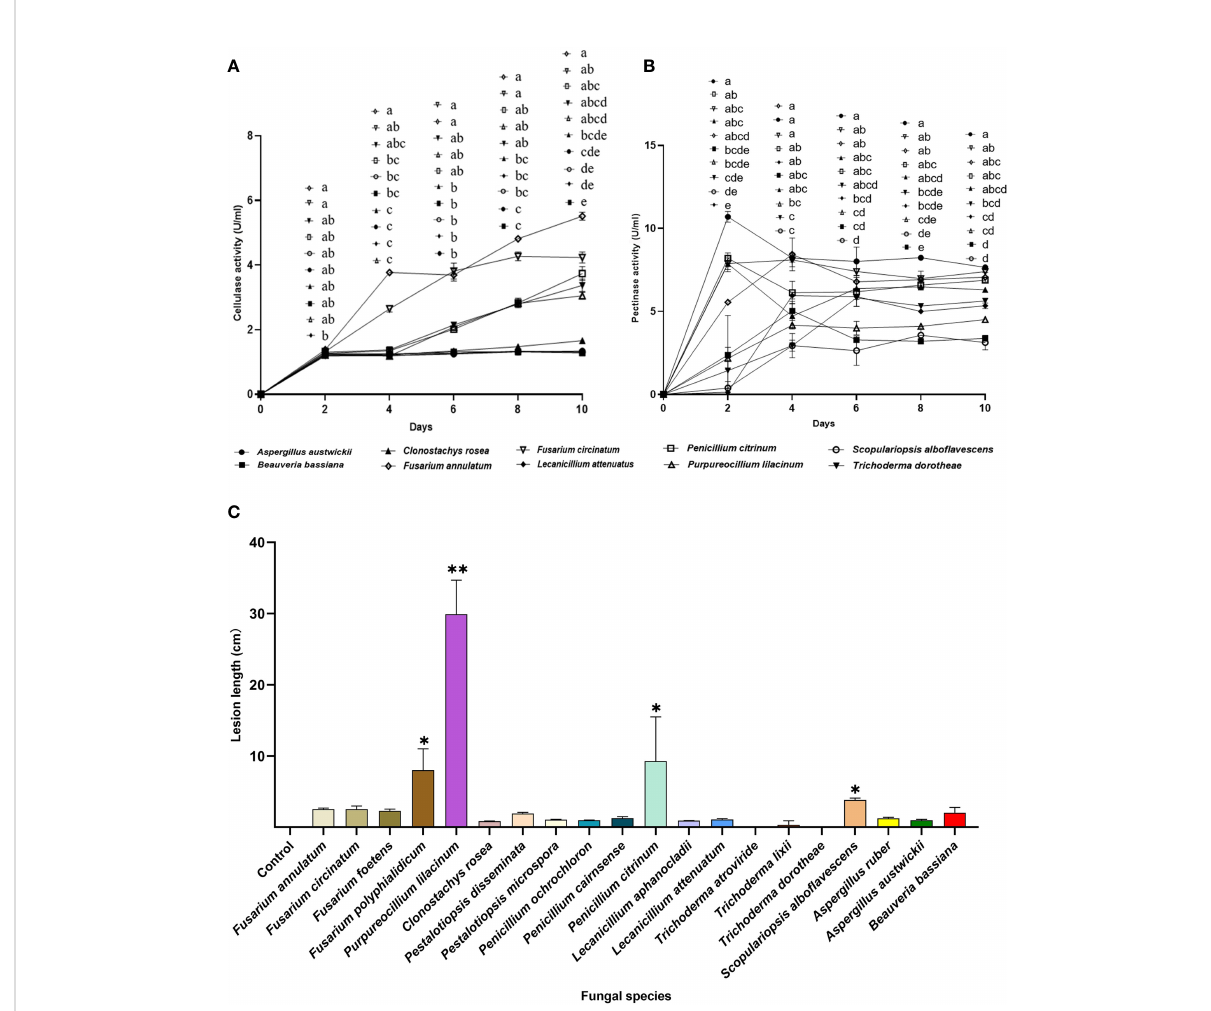
FIGURE 7 Phytopathogenic activities of the entomopathogenic fungi to the host pine P . massoniana. (A) Cellulase activities of fermentation supernatants from fungal species. (B) Pectinase activity of fermentation supernatants from fungal species. (C) Lesion lengths caused by fungi after 3 weeks. In A and B, different letters mean signi fi cant differences among fungi at each time point ( P< 0.05); In C, asterisks on bars mean signi fi cant difference between the control group and fungal species (* P< 0.05; ** P< 0.01). Data were represented as Mean ±